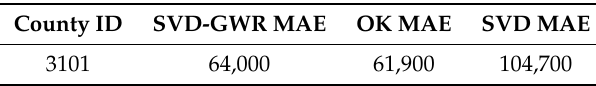
Table 9. GWR over OK without Outliers in